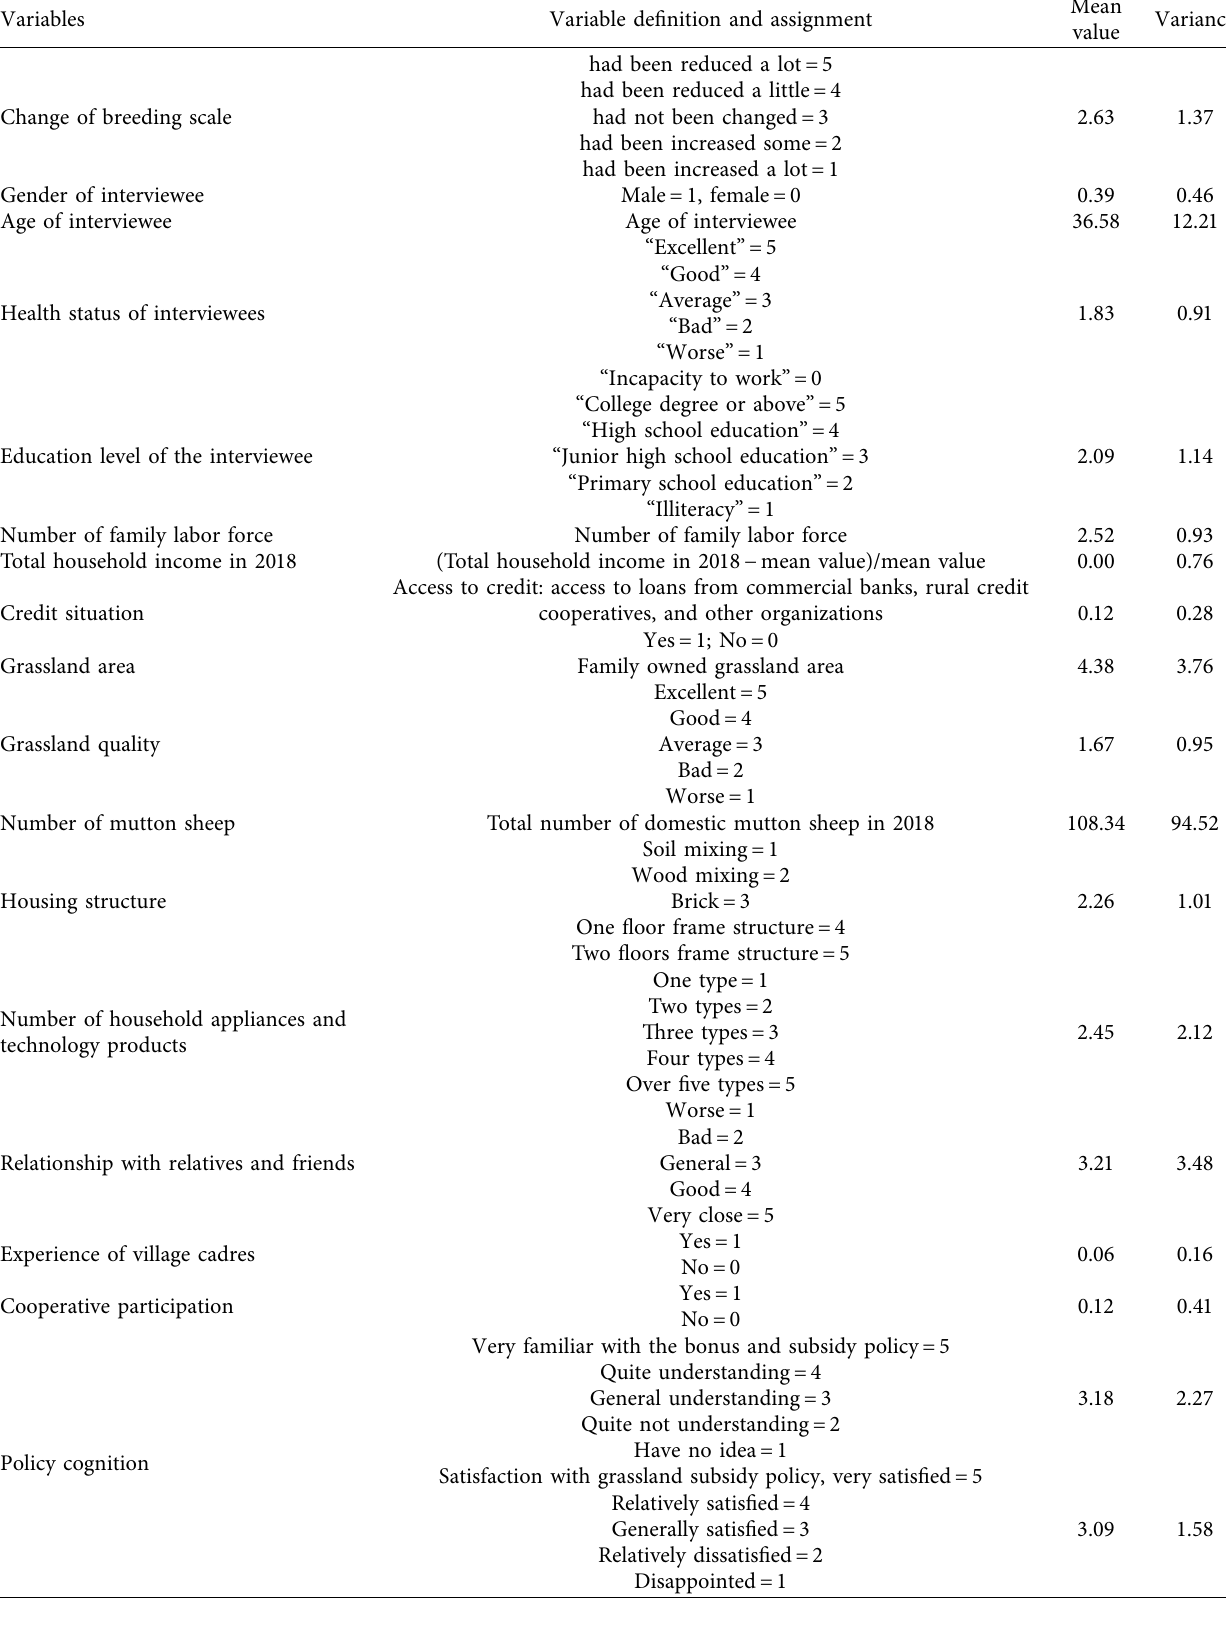
Table 1: Meaning of relevant variables and statistical